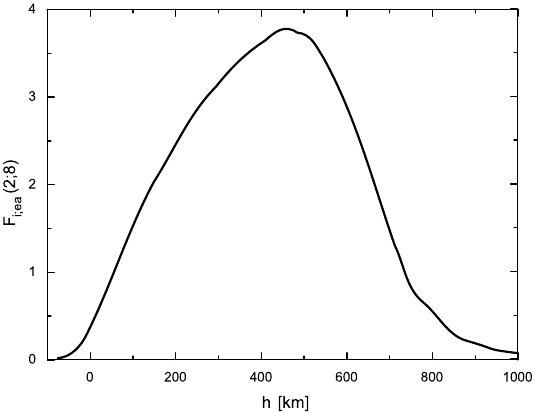
( n ) given by Eq. (14), as a function of height h. i ; ea